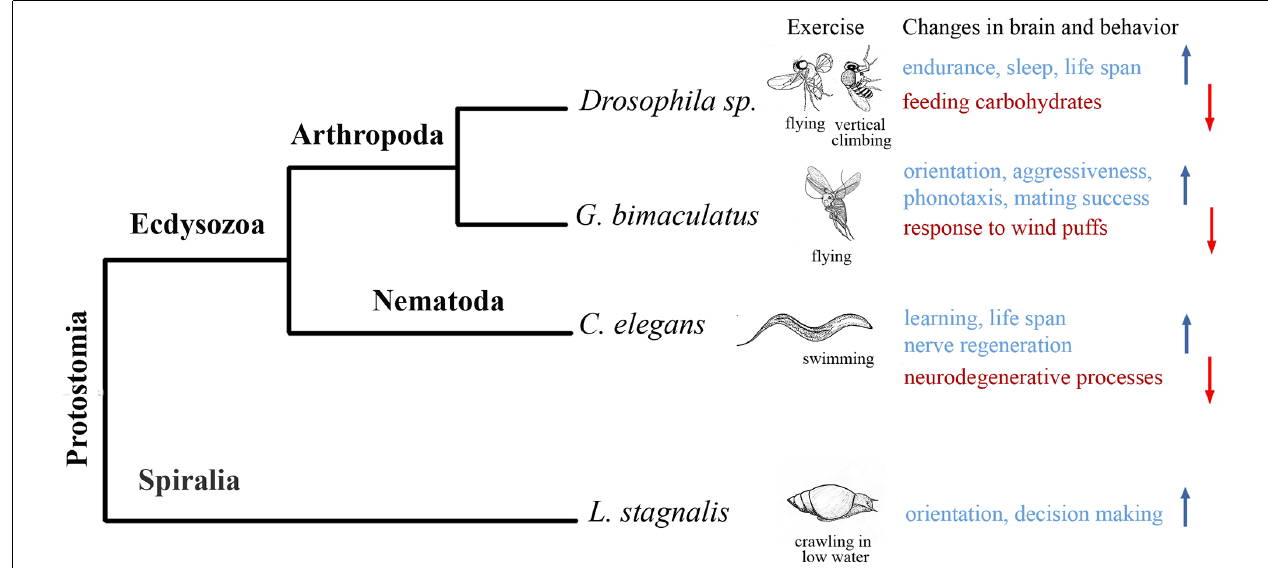
FIGURE 1 | Effects of exercise (species-specific intense locomotion) on representatives of three big clades of Protostomes. Phylogenetic tree displaying the different species analyzed to study the effects of exercise on behavior and nervous system. The species are listed not in the order of appearance in the manuscript. Silhouettes are only illustrative. Species-specific forms of intense locomotion that were used as exercise are listed under the silhouettes. Exercise-induced changes in the brain and behavior are shown in color. Red color and down head arrow indicate downregulation, blue color and upward arrow indicate upregulation. In Drosophila , flying and or/vertical climbing increased endurance and life span, improved sleep and feeding behavior (for review, Watanabe and Riddle, 2019). In G. bimaculatus , flight improved orientation via conspecific phonotaxis (Sergejeva and Popov, 1994; Mezheritskiy et al., 2020), enhanced aggressiveness (Hofmann and Stevenson, 2000; Stevenson et al., 2005), promoted mating (Dyakonova and Krushinsky, 2008). In C. elegans , swimming protected against neurodegeneration, improved associative learning (Laranjeiro et al., 2019), accelerated nerve regeneration (Kumar et al., 2021). In L. stagnalis , previous terrestrial crawling increased activity and facilitated the decision making in novel environment (Korshunova et al.,